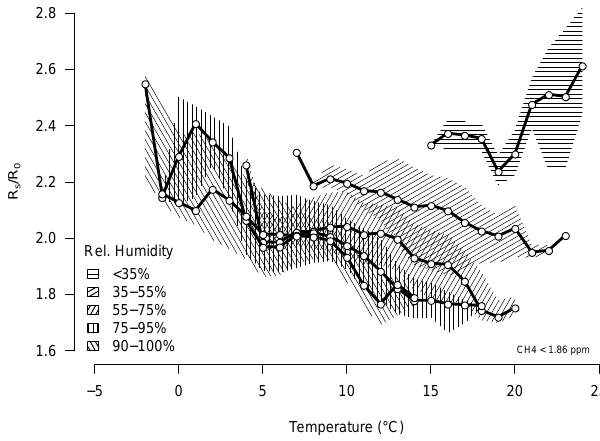
Fig. 3. Observed sensor sensitivity to ambient temperature and rel- ative humidity at CH 4 concentrations < 1 . 86ppm during the full 2011 field season at Toolik Lake. At relative humidities ≥ 35%, the sensor resistance ratio follows the expected curves in Fig. 1b with an offset, but if the air is too dry (relative humidity < 35%), the sensor does not provide reliable data that could be used to quantify CH 4 concentrations. Each curve and shaded area shows the binned median and interquartile range, respectively, of the selected range of relative humidities (see legend). Temperature bins were chosen 2 ◦ C wide with 50%